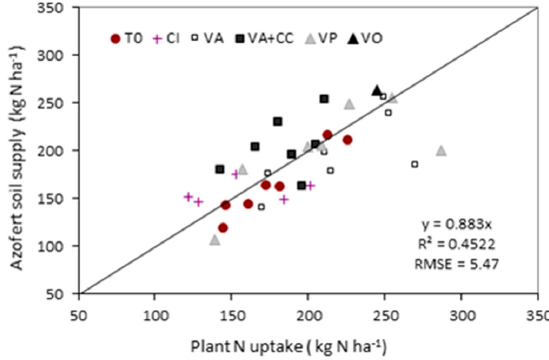
Figure 4. Comparison of the N uptake by plants in the control plots (no mineral fertiliser) receiving different organic sources and the N supply estimated using AzoFert ® software. T0: no organic application, CC: cover crop, VA: vinasse applied in August, VA + CC: vinasse applied in August + cover crop, VP: vinasse applied in February, VO: vinasse applied in October.